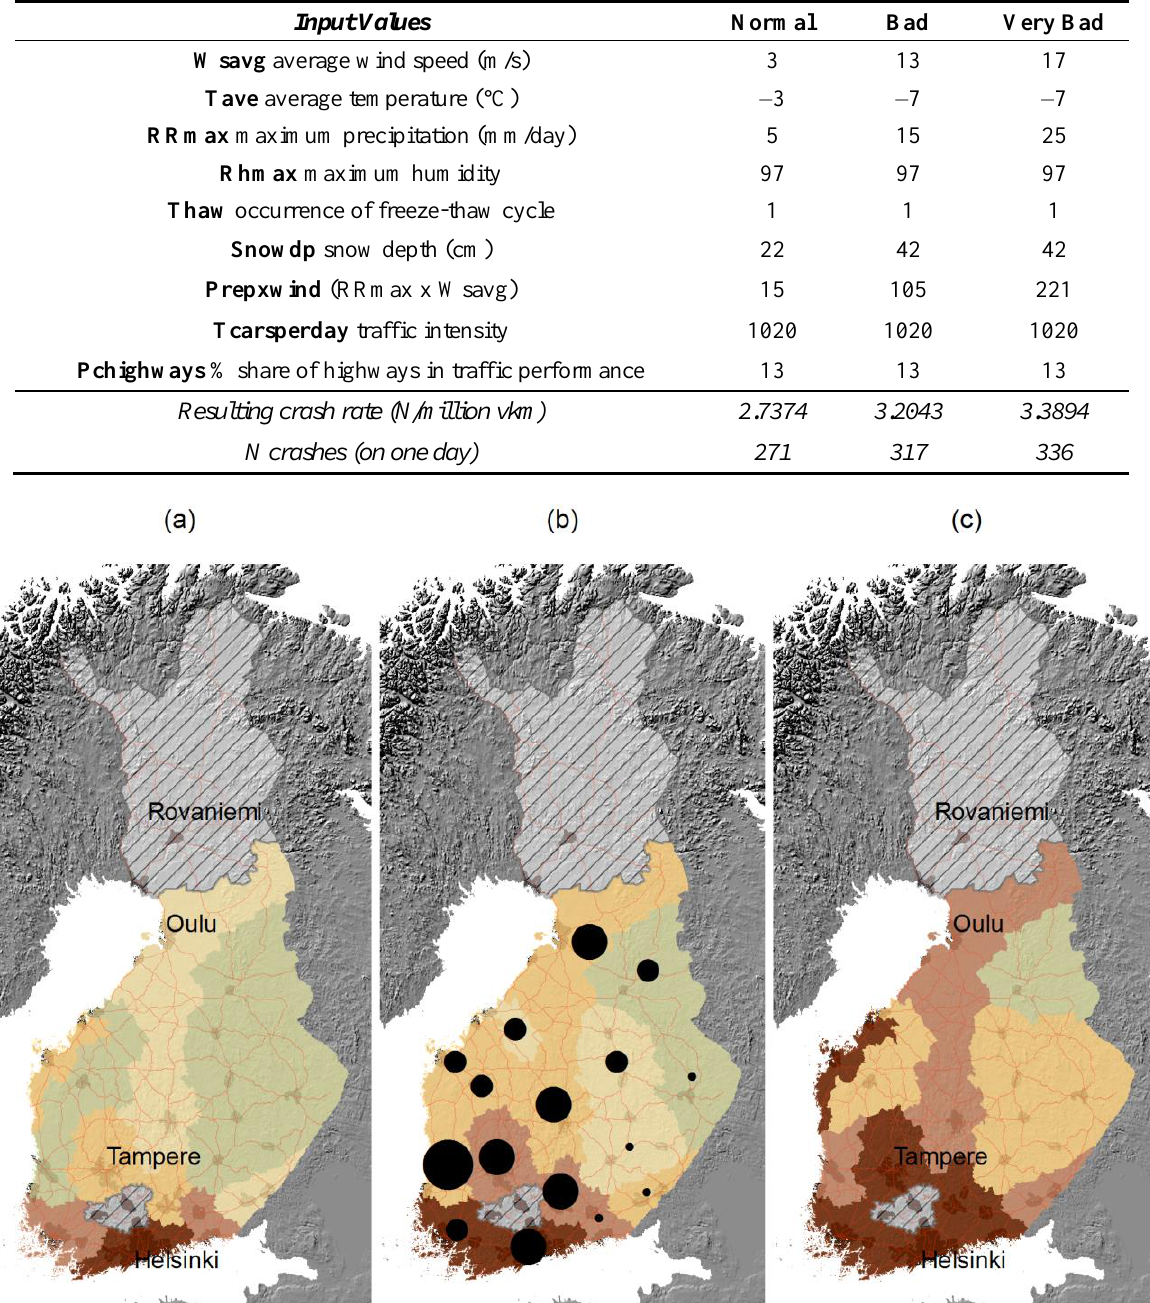
Table 4. Illustration of effects of different levels of input variables reflecting different weather conditions.